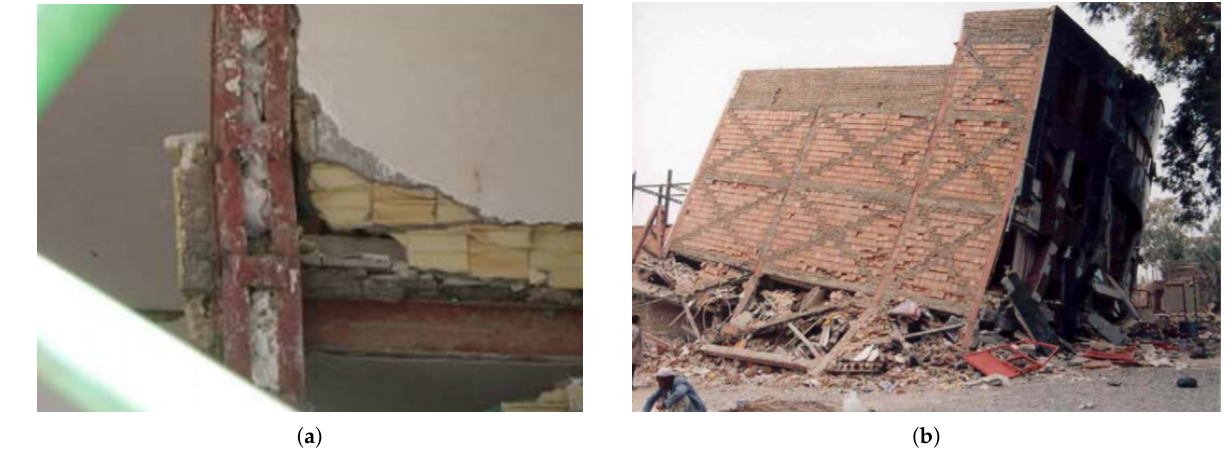
Figure 6. Other types of failures in structural systems [34]; ( a ) buckling of a column in ground floor connected to the balcony beam; ( b ) inappropriate lateral bracing system and longer length of first floor column led to a soft story building.